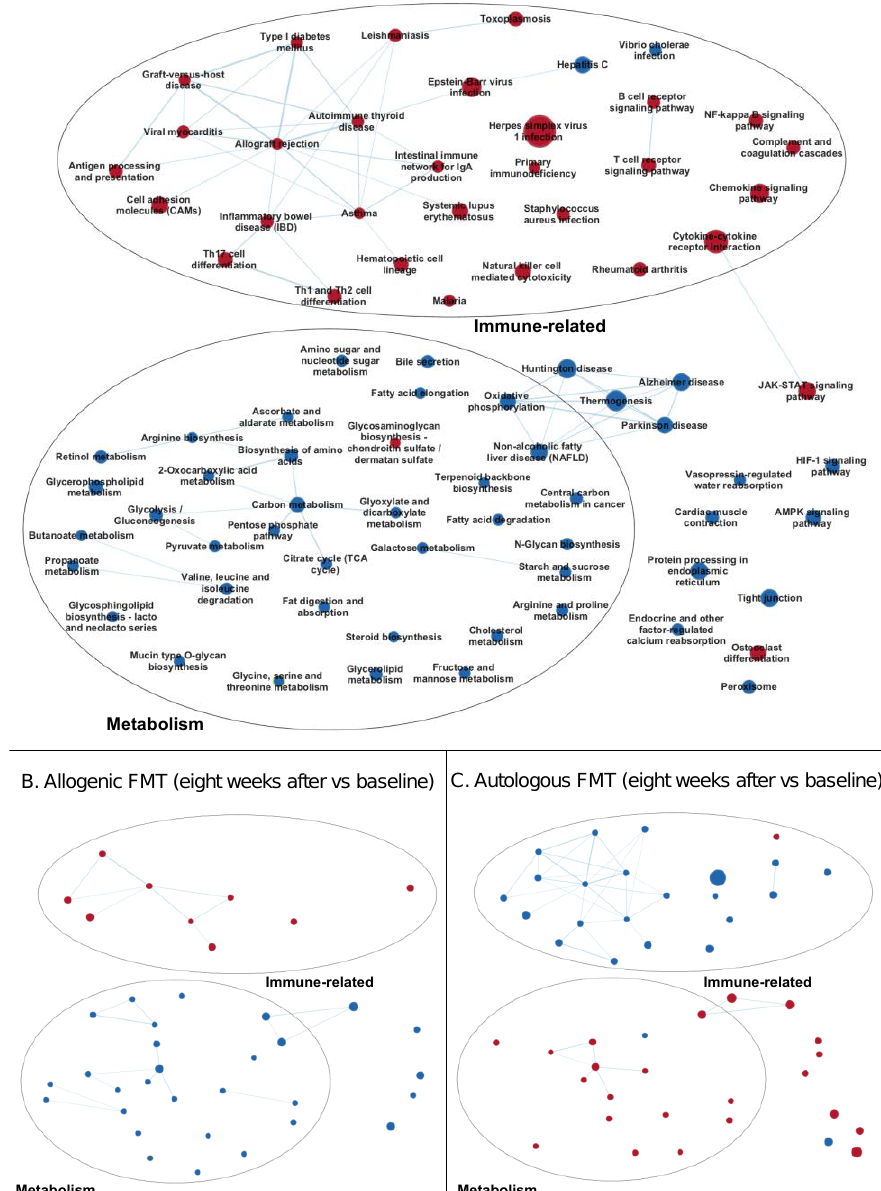
Figure 4. Enrichment maps of gene sets changed eight weeks after FMT. ( A ) Allogenic versus autologous FMT (baseline-corrected). ( B ) Allogenic FMT (within-group comparison). ( C ) Autologous FMT (within-group comparison). Nodes represent KEGG gene sets, and the edges between the nodes represent their similarity. Red nodes indicate enriched (increased expression of) gene sets, and blue nodes indicate suppressed (decreased expression of) gene sets. Node size represents the number of genes in the gene set, and the thickness of the edges indicates the degree of overlap between the two connected gene sets (nodes). The gene sets are manually grouped according to their biological functions among these gene sets. See Supplemental Figure S2 for the enrichment map including the names of all the gene sets. Gene sets that were di ff erentially regulated (FDR < 0.25) between the allogenic and autologous FMT after eight weeks were used as input for the enrichment map, and for better visualization, only the gene sets among those with FDR < 0.05 in the three depicted comparisons are